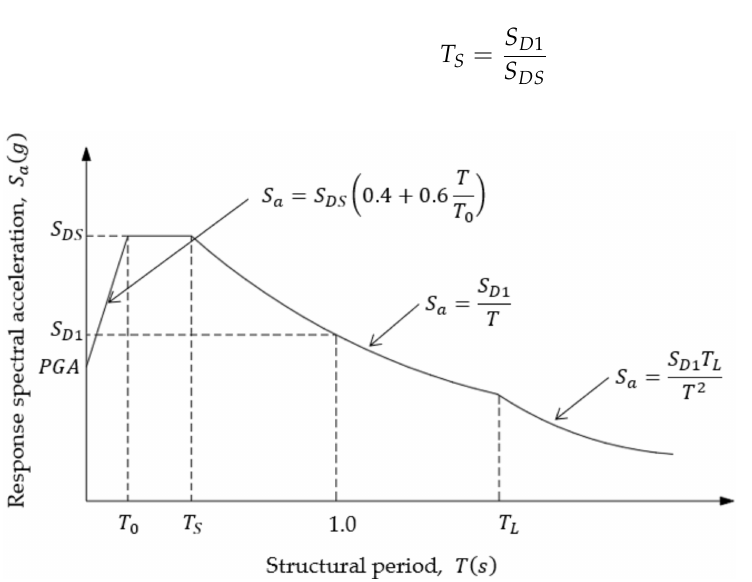
Figure 16. Seismic elastic design spectrum for site class A to